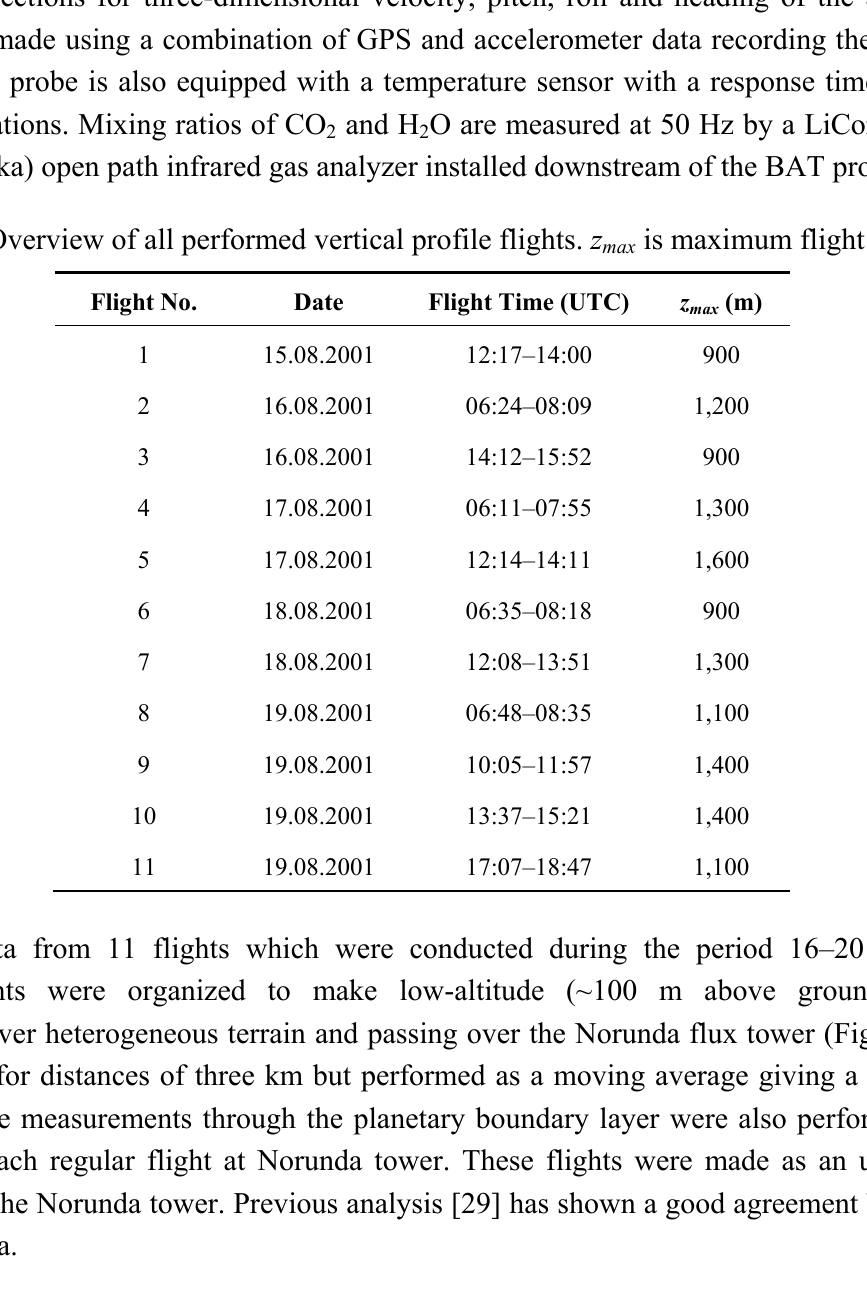
is maximum flight altitude. max